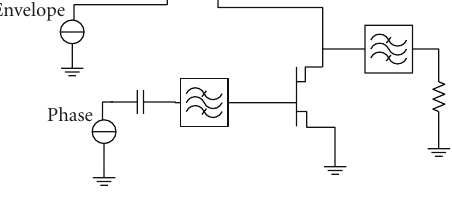
Figure 5: EER architecture.